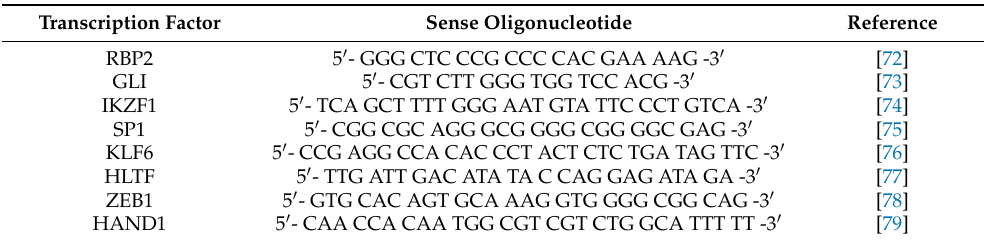
Table 3. Sequence of oligonucleotides corresponding to consensus binding sites for different tran- scription factors used in EMSA